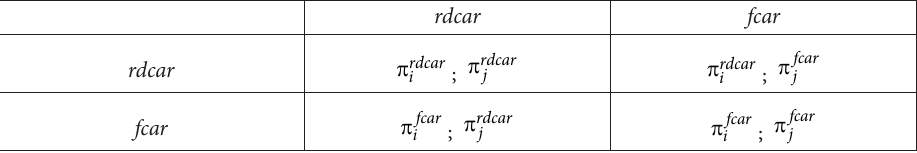
Table 4. Simplified profit-based decision table for R&D strategies